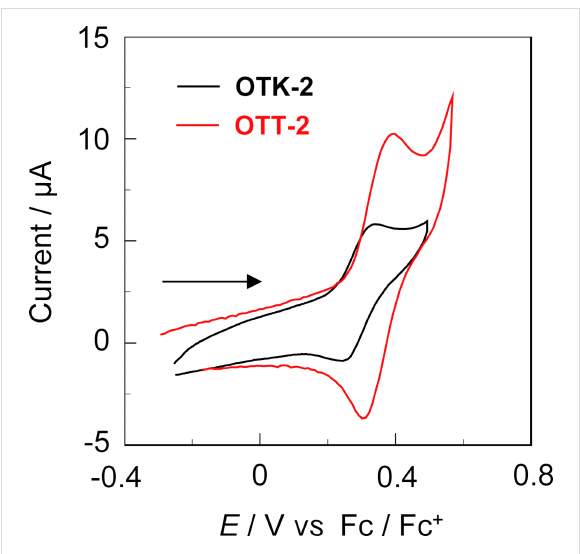
Figure 2: Cyclic voltammograms of OTK-2 and OTT-2 (0.1 mM) in DMF containing 0.1 M Bu 4 NClO 4 at a scan rate of 100 mV s − 1 . The arrow denotes the direction of the potential